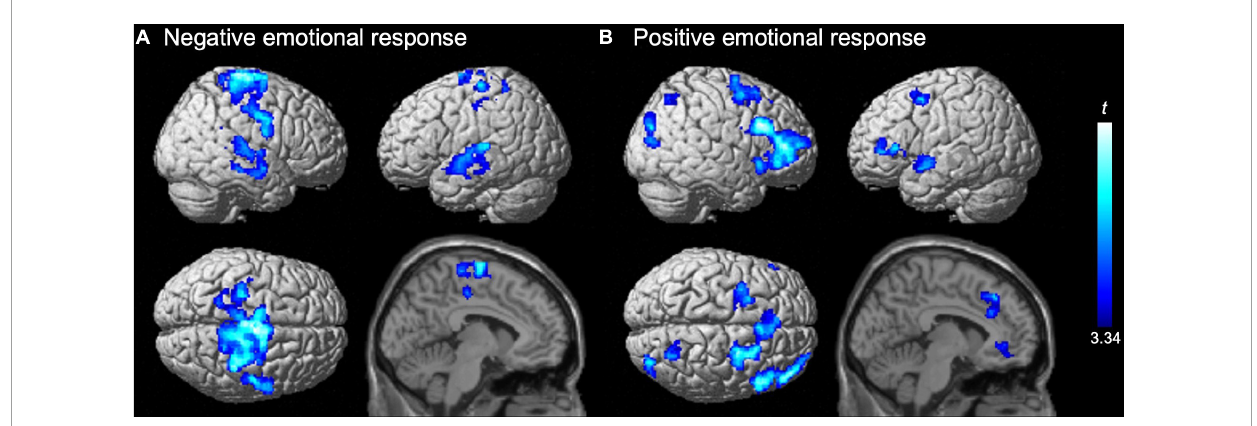
FIGURE2 Negative effects of the emotion regulation trait on activation for (A) negative and (B) positive emotional responses. Significant effects ( t -values) of the emotion regulation score (power to live questionnaire) in the second-level multiple regression model are represented by a blue-cyan scale, rendered on the surface and overlaid on the parasagittal section ( x = –6) of an SPM12 standard structural brain image. Statistical significance was determined at a cluster-forming threshold of uncorrected p < 0.001 and then corrected to p < 0.05 (family wise error) for the cluster size. No positive trait effect was